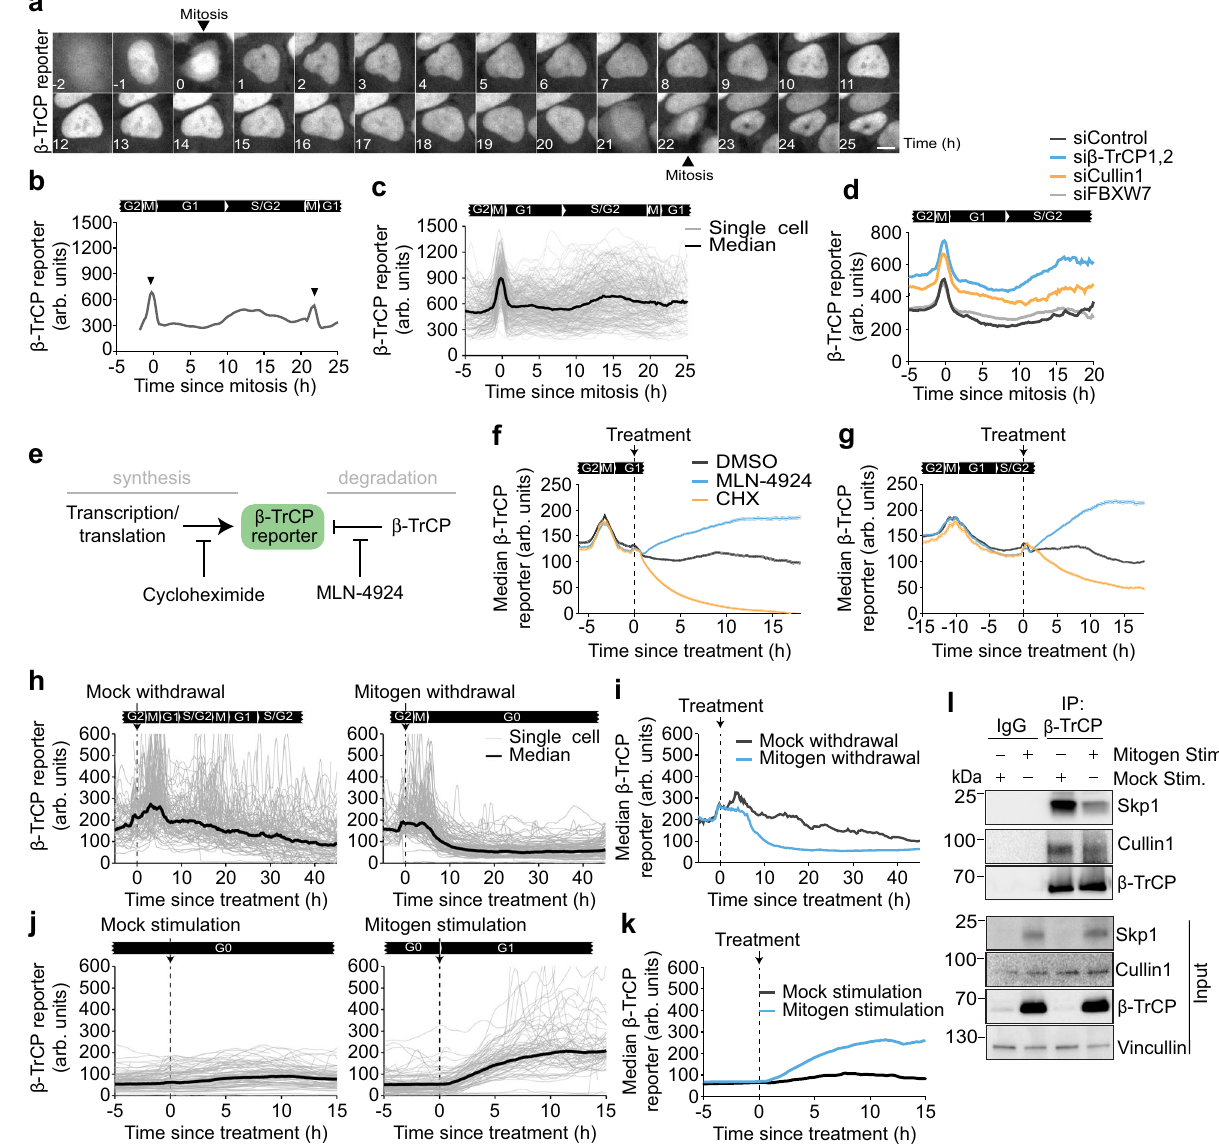
Fig.3| β -TrCPactivityisdynamicallyregulatedduringcellcycleentryandexit. a Imagemontageofasingle-cellexpressingthe β -TrCPreporter.Imagesweretaken at the indicated time (h) relative to mitosis. Scale bar is 10 μ m. b Representative trace of β -TrCP reporter levels in a single HeLa cell. Note the arti fi cial increase in fl uorescence intensity during mitosis (black arrow) due to cell rounding and nuclear envelope breakdown. c Single-cell and median β -TrCP reporter levels in HeLacellsalignedtomitosis. N =263cells. d Median β -TrCPreporterlevelsinHeLa